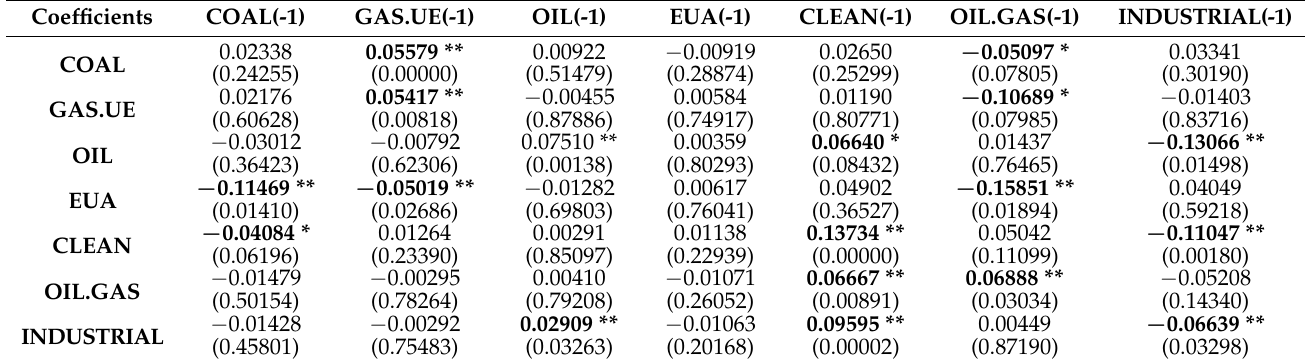
Table 3. Estimated coefficients of the VAR(1) model (the significant coefficients are in bold